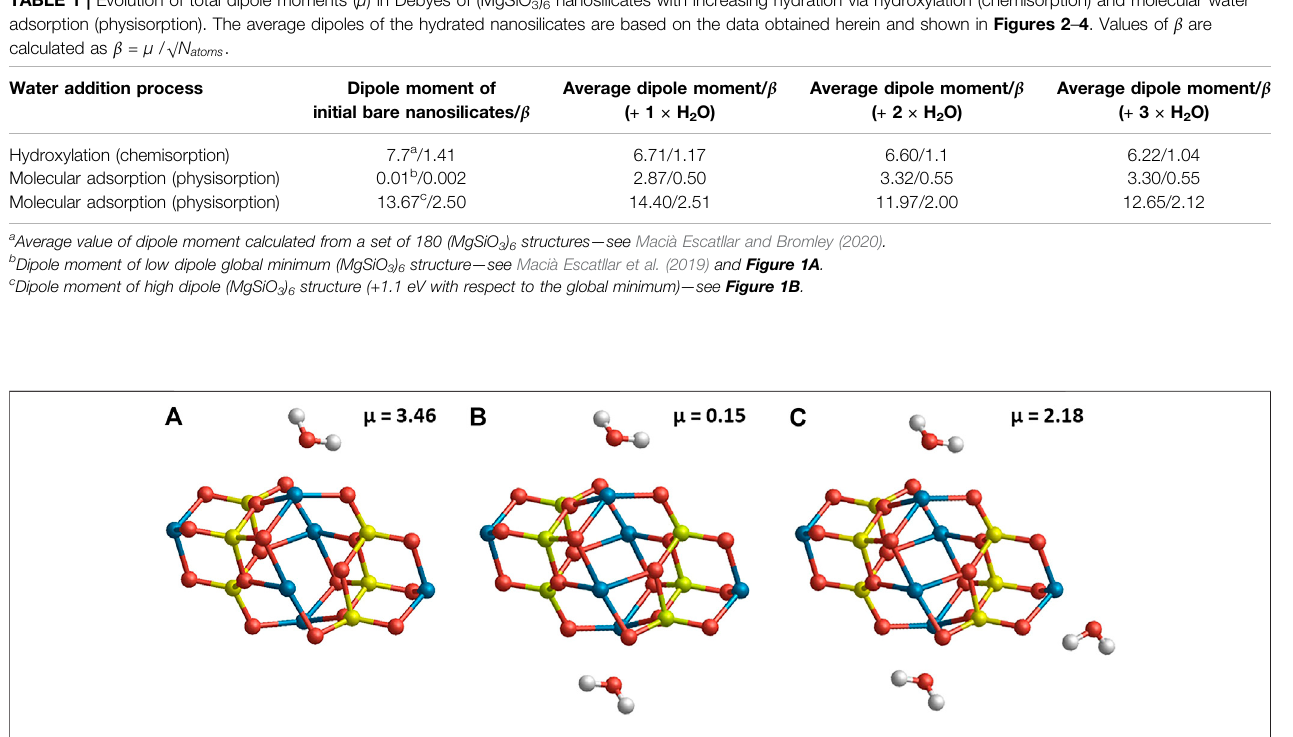
Frontiers in Astronomy and Space Sciences |